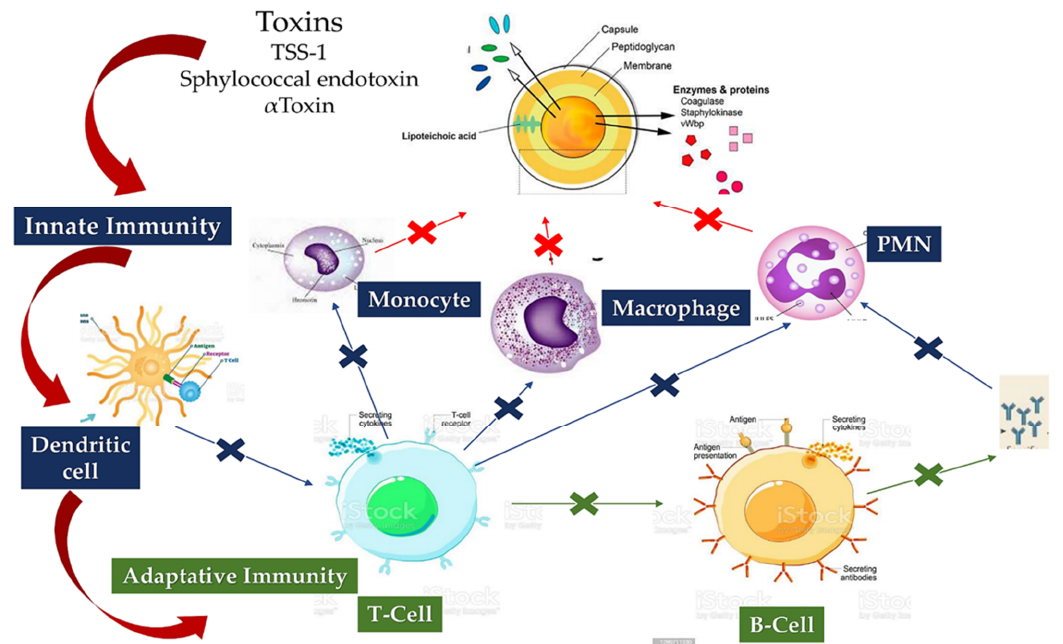
Figure 8. Staphylocytotoxins interfere (great blue arrow) with the cells of the innate ( blue box ) and adaptive (green box) immune response. Cytoxins (TSS-1, Staphylococcal endotoxin, and alpha toxin) are capable of lysing immune cells, including PMN, monocytes, and macrophages involved in the clearance of S. aureus (red arrow). Cytotoxins can also impair the function of adaptive immune cells (green arrows) represented by T and B lymphocytes. Finally, cytotoxins can impair the interaction between innate and adaptive immune cells (blue arrows). Abbreviation: TSS-1, Toxic Shock Syn- drome-1.